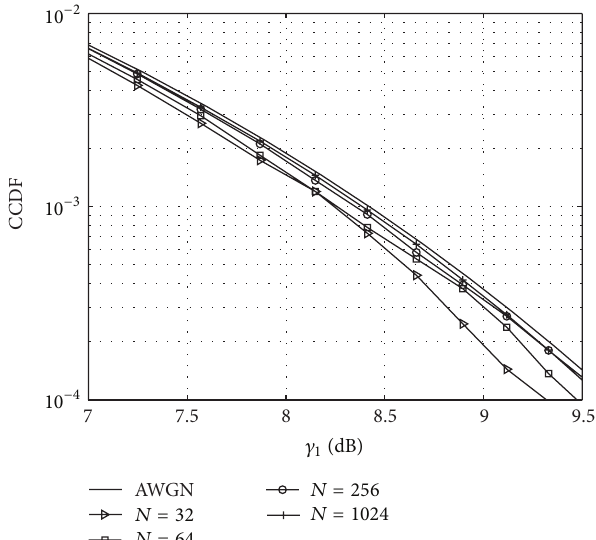
Figure 2: CCDF of the FBMC signal as a function of the number of subcarriers.